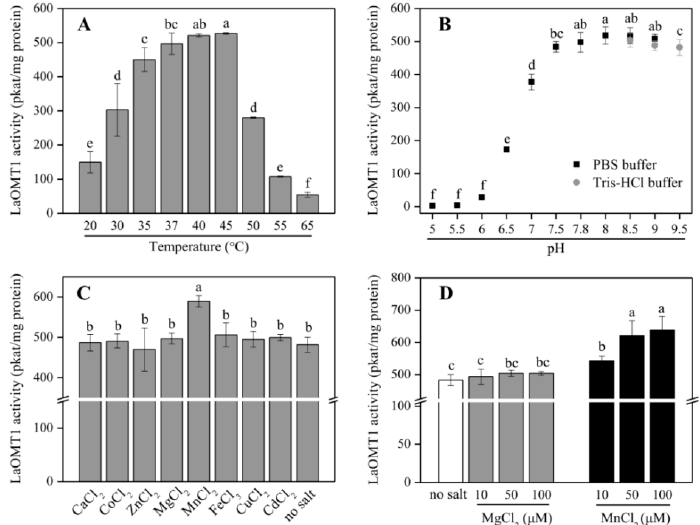
Figure 3. Effect of temperature ( A ), pH ( B ), divalent cations ( C ), and different concentrations of MgCl 2 and MnCl 2 ( D ) on LaOMT1 enzyme activity for 3,4-dihydroxybenzaldehyde. The tests contained 1 mM 3,4-dihydroxybenzaldehyde in the assay mixture. 2.3. Expression Analysis of LaOMT1 and Accumulation of Amaryllidaceae Alkaloids in Different Tissues The expression profiles of the LaOMT1 in different tissues including root, bulb, leaf, flower stalk, and different parts of flowers (petal, column, filament and ovary) were evaluated by using quantitative real-time PCR (qRT-PCR) analysis. The results showed that LaOMT1 ubiquitously expressed in all tissues detected, with the highest expression level in the ovary (Figure 4A). Meanwhile, the contents of three Amaryllidaceae alkaloids including lycorine, glanthamine, and narciclasine were measured . The results showed that the largest concentration of lycorine was found in ovary tissue, whereas, the lowest level in the flower stalk. Similar result was observed for the determination of galanthamine. However, the highest concentration of narciclasine was found in the bulb, with the lowest level in flower stalk (Figure 4B). Figure 4. Expression level of the LaOMT1 gene ( A ) and accumulation level of three Amaryllidaceae alkaloids ( B ) in different tissues of L. aurea . The expression level of LaOMT1 was measured using qRT-PCR analysis, and normalized to the reference gene LaEXP1 . The expression of LaOMT1 in root tissue was defined as 1.0. Data represent the mean ± standard deviation (SD) of three independent biological replicates. Different letters indicate significant differences ( p < 0.05) according Duncan’s multiple test.